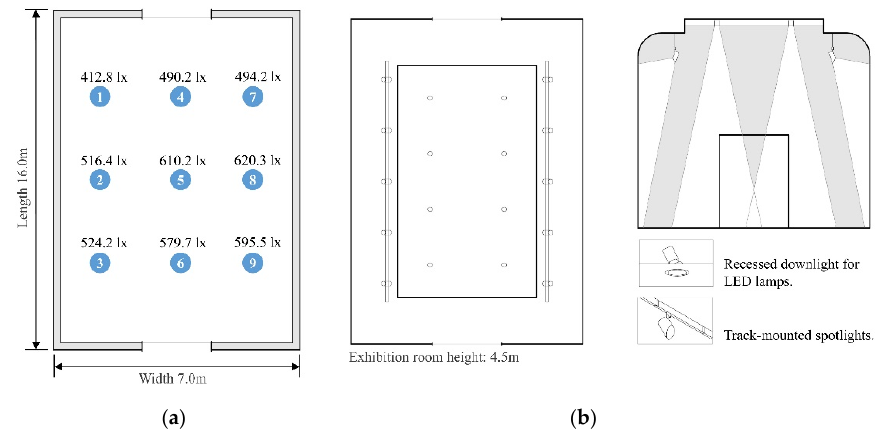
Figure 9. The Yamazaki Mazak museum of art building interior. ( a ) Illuminance plane spot test. ( b ) The arrangement and elevation of the mixed lighting display source.